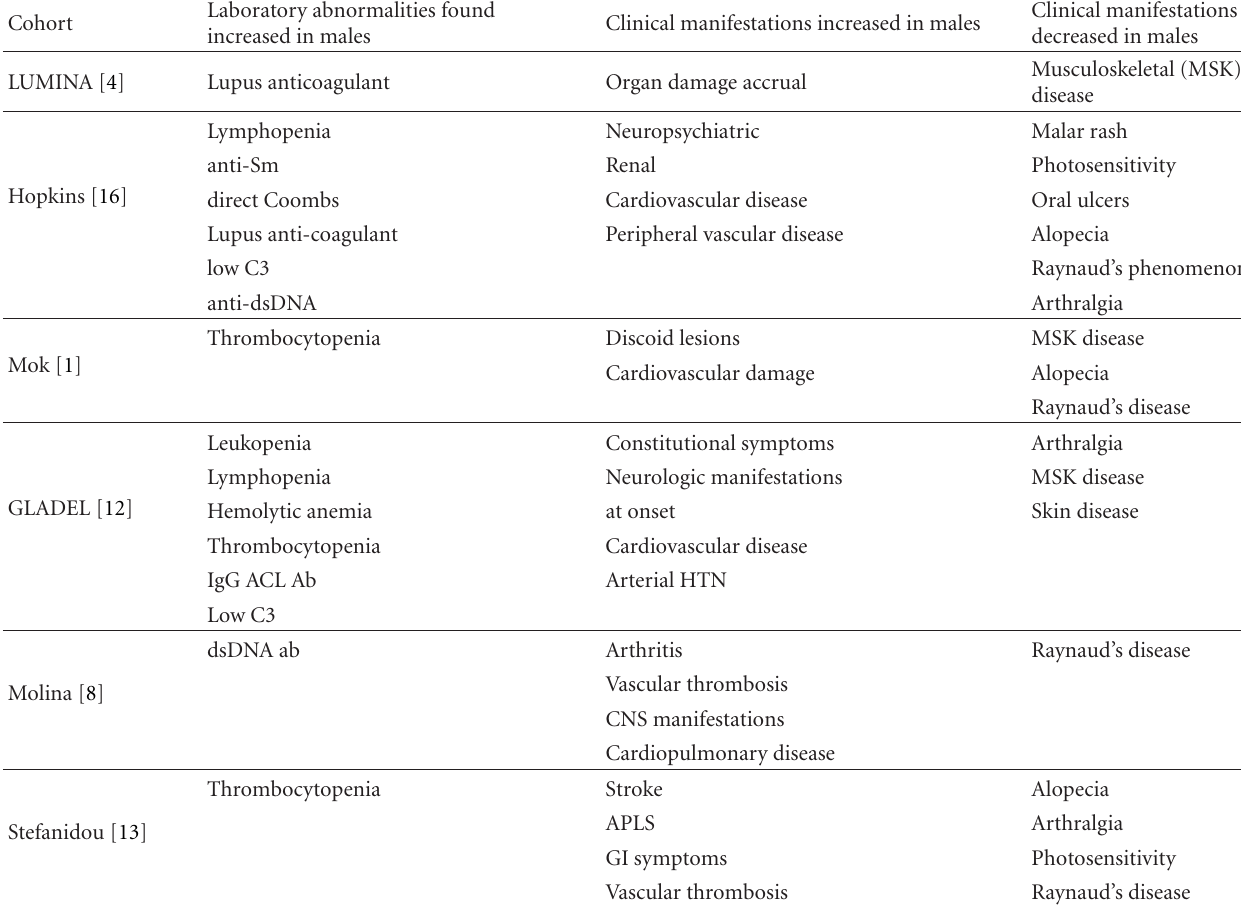
Table 1: Nonrenal manifestations of SLE more prominent in males by